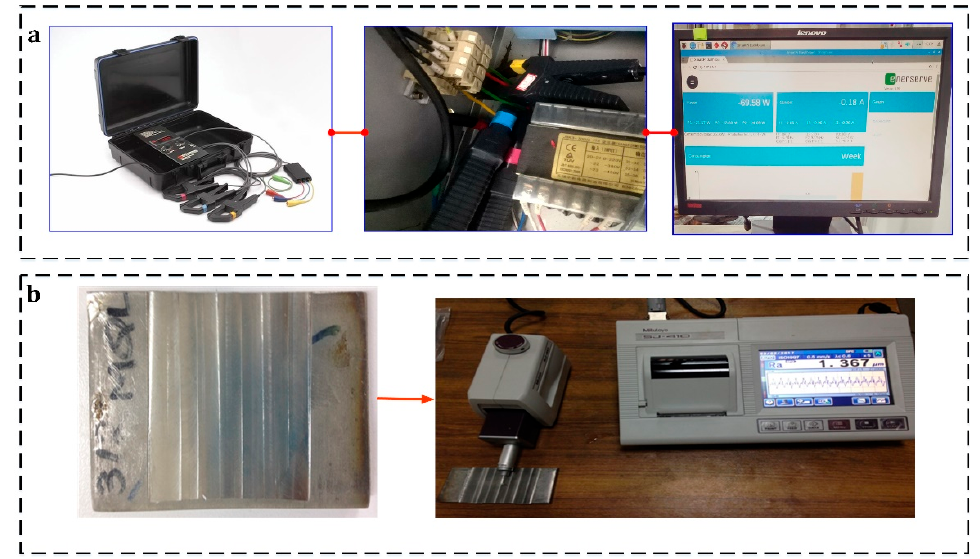
Figure 4. Experimental equipment used, showing: ( a ) power measurement using a Portable Power Cell PPC-3 ( b ) surface roughness measurement.